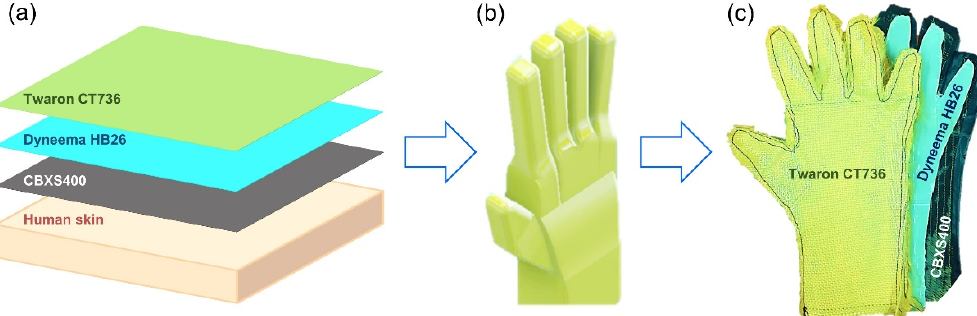
Figure 19. The glove model: ( a ) modeled construction design of the space glove including materials (from the left: Twaron CT736, Dyneema HB26, CBXS400, astronaut’s skin), ( b ) model of the EVA type space glove prototype for cosmonaut, ( c ) photo of the gloves used to construct the EVA type space glove prototype for astronaut.